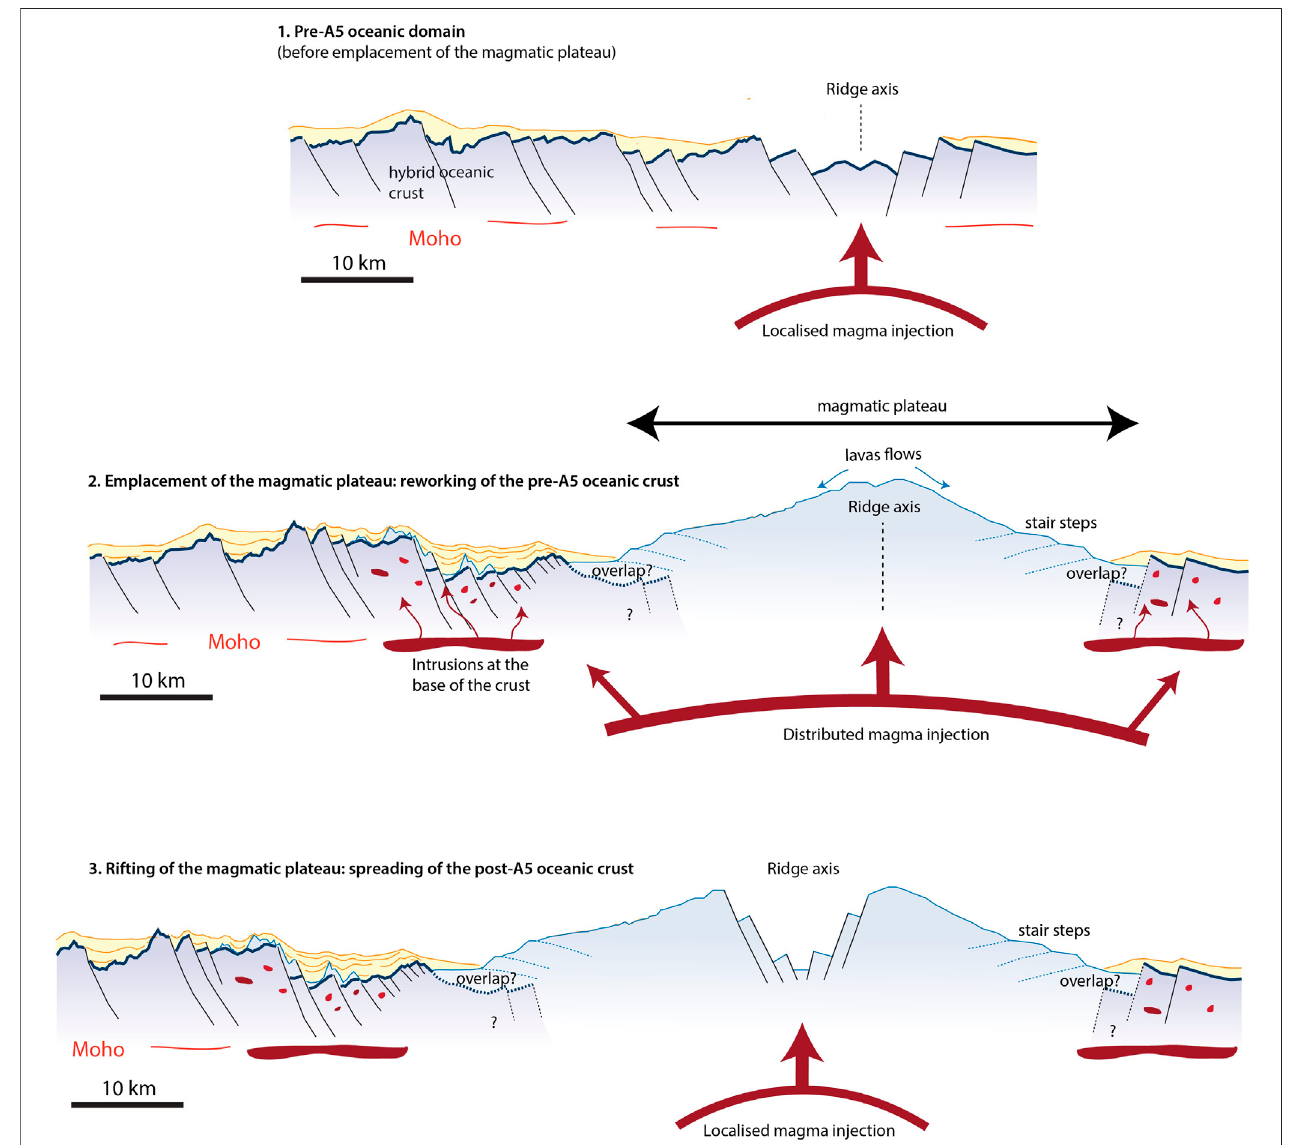
FIGURE 11 | Figure showing the pre-A5 oceanic domain before (A) and after (B) the emplacement of the magmatic plateau. Stage (C) shows the rifting of the magmatic plateau and the onset of spreading of the post-A5 oceanic crust.